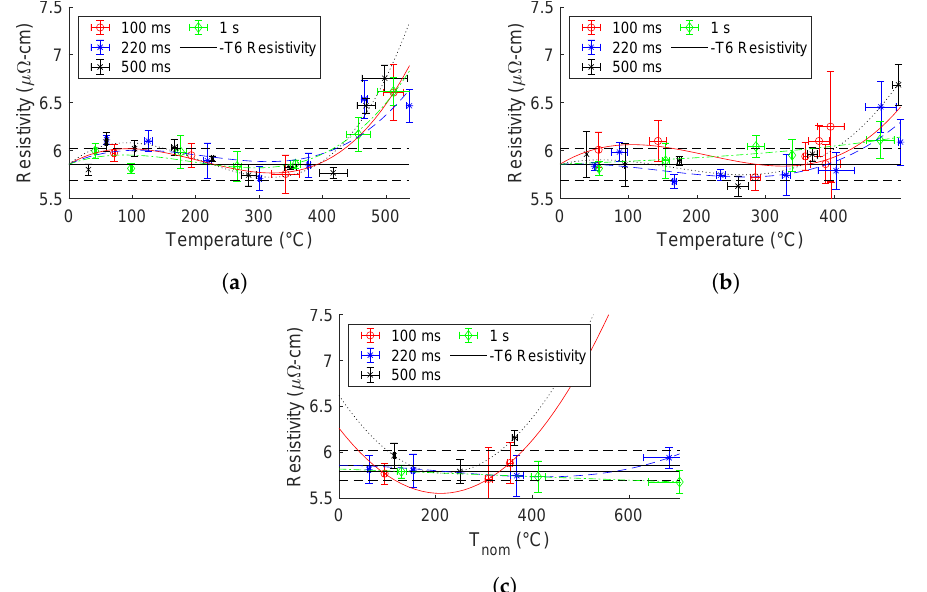
Figure A4. Attempted trend line fitting to DC test data; ( a ) Air-cooled, air-quenched, ( b ) air-cooled, water-quenched, ( c ) water-cooled, water-quenched, Temperature values are non-physical.